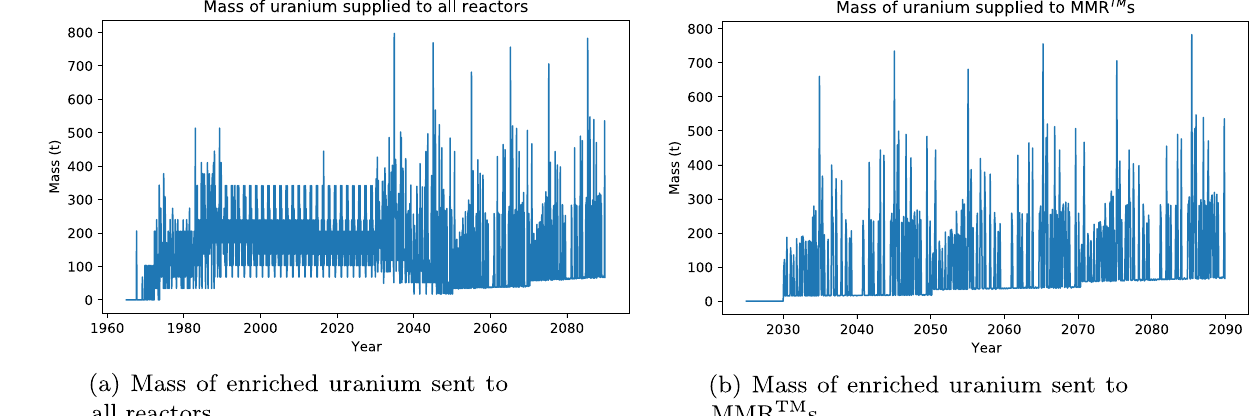
Fig. 12. Enriched uranium mass sent to reactors in Scenario 4.